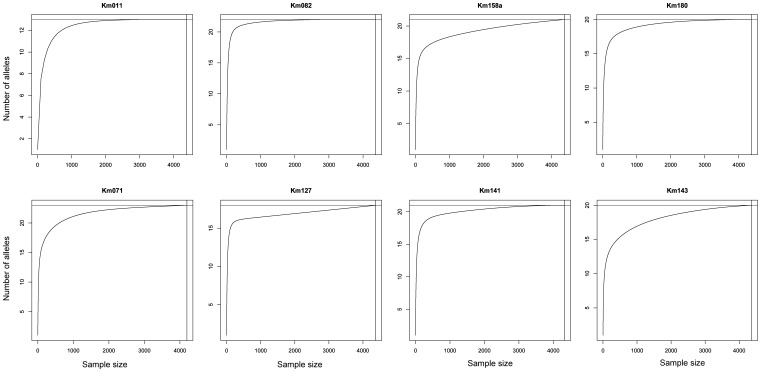
Allelic richness accumulation curves for each locus.Rarefaction curves were produced in the R statistical environment [69].